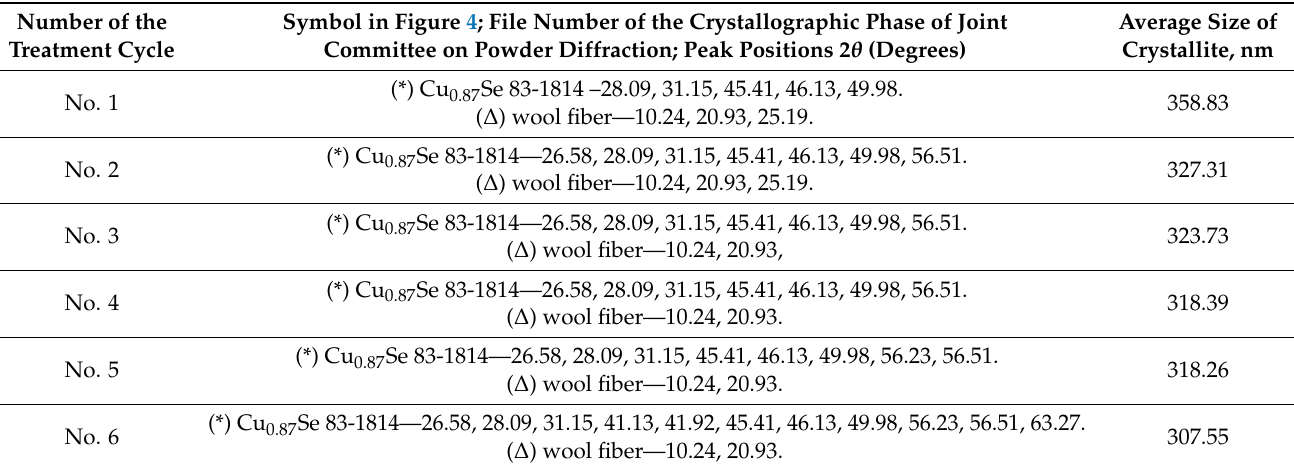
Table 2. XRD 2 θ peaks and their ascription of a coating of Cu x Se formed on the wool fiber surface. Number of the Symbol in Figure 4; File Number of the Crystallographic Phase of Joint Treatment Cycle Committee on Powder Diffraction; Peak Positions 2 θ (Degrees)